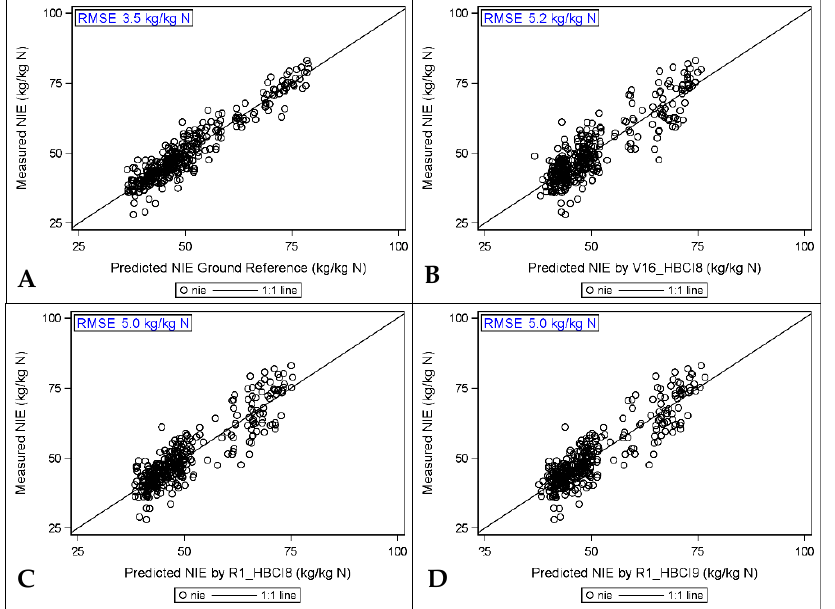
Figure 8. Predicted vs. actual (measured) estimates of NIE with RMSE for each plot. The black line is the 45° reference line (1:1 line). ( A ) Ground reference mixed model; ( B ) V16 HBCI8 model; ( C ) R1 HBCI8 model; ( D ) R1 HBCI9 model.